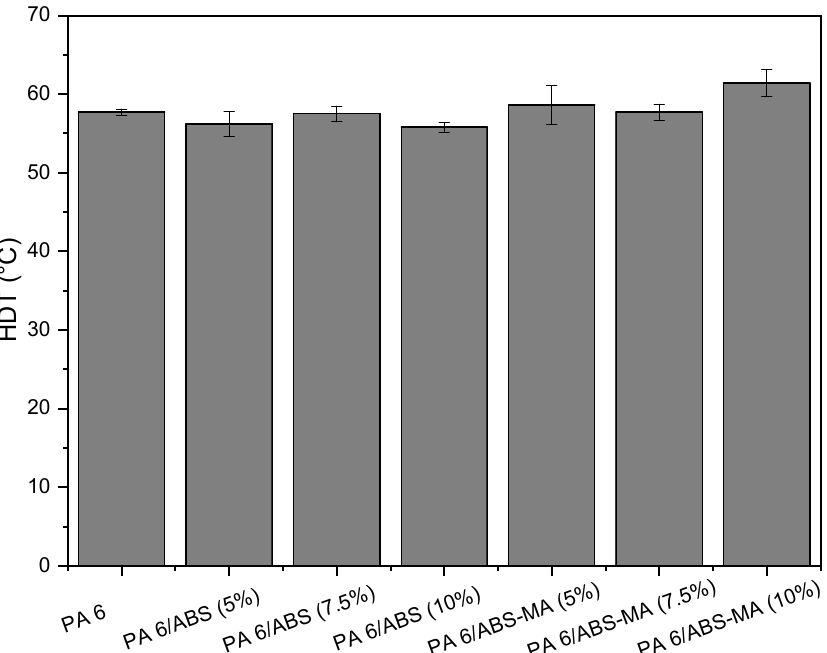
Figure 13. Heat deflection temperature of PA6 and its binary blends as a function of ABS-MA and ABS content, respectively.